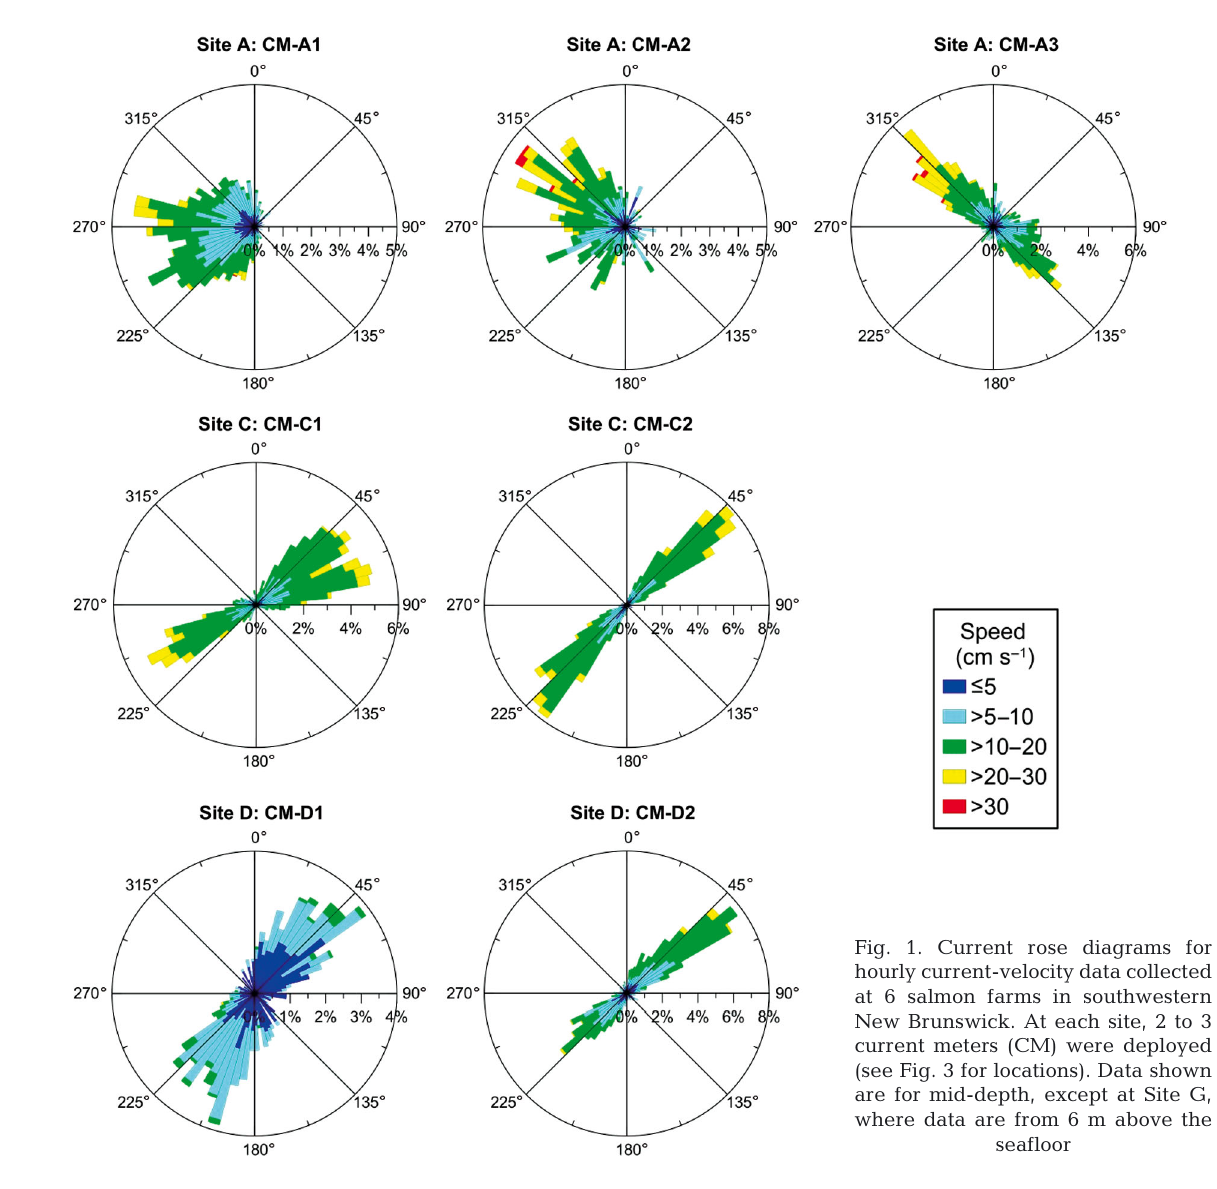
model domain. Fig. 2 shows the relationship when the model was run with resuspension using 1 mo feeding rates; the relationship was similar using 3 mo feeding rates (not shown). With both feed ing rate periods, when about half or more of the near-bottom current speed records were above the re suspension threshold, <5% of waste particles remained within the model domain (with re sus pension); when fewer current records were above this threshold, more par- ticles remained in the model domain. Consequently, resuspension caused almost all particles to be trans- ported out side the model domain at Sites A, C, and I, while at the other sites, the percent of particles remaining in the domain was higher.